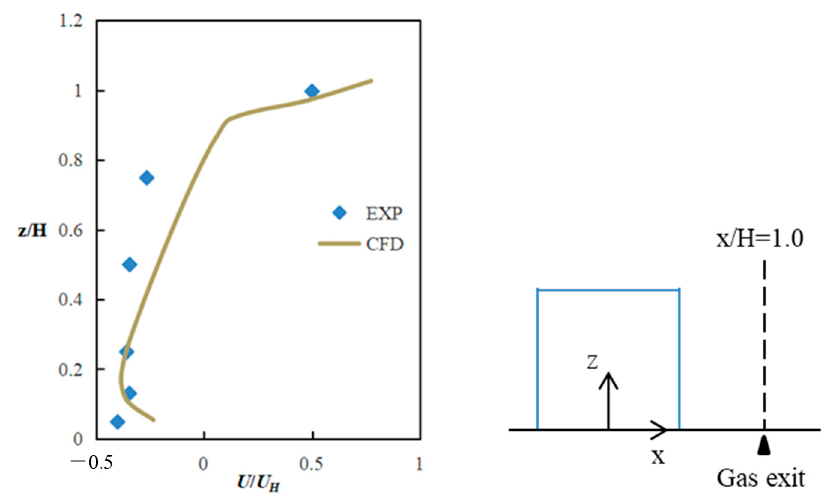
Figure 3. Comparison of the normalized wind velocity at a center section (y/H = 0).